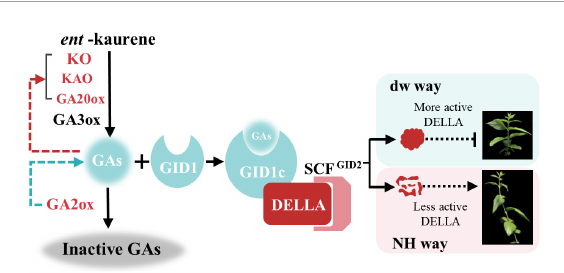
FIGURE9 Model of plant height regulation in C. praecox (dw and NH). In the synthesis pathway, the red character indicates the up-regulated gene in dw. The red arrow indicates that decreased GA content promotes the up-regulation of synthetic gene expression, and the green arrow indicates that GA2ox reduces the active GA. In the signal transduction pathway, short vertical lines represent more active DELLA proteins that inhibit the elongation of C. praecox branches, while dotted arrows represent less active DELLA proteins that allow normal C. praecox